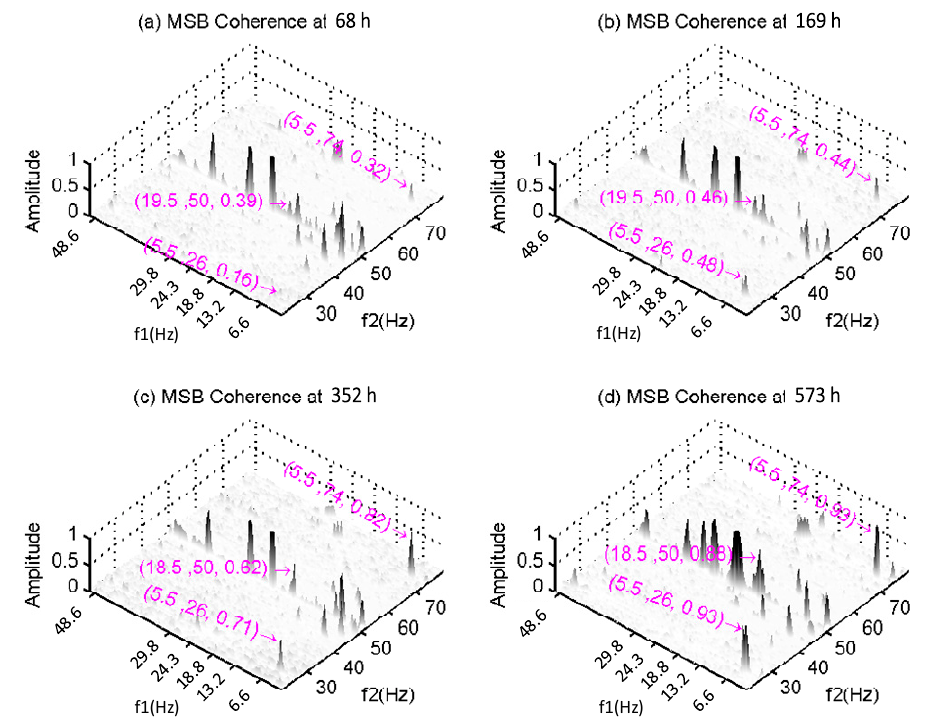
Figure 9. MSB coherences for gearbox deterioration at successive time instants.